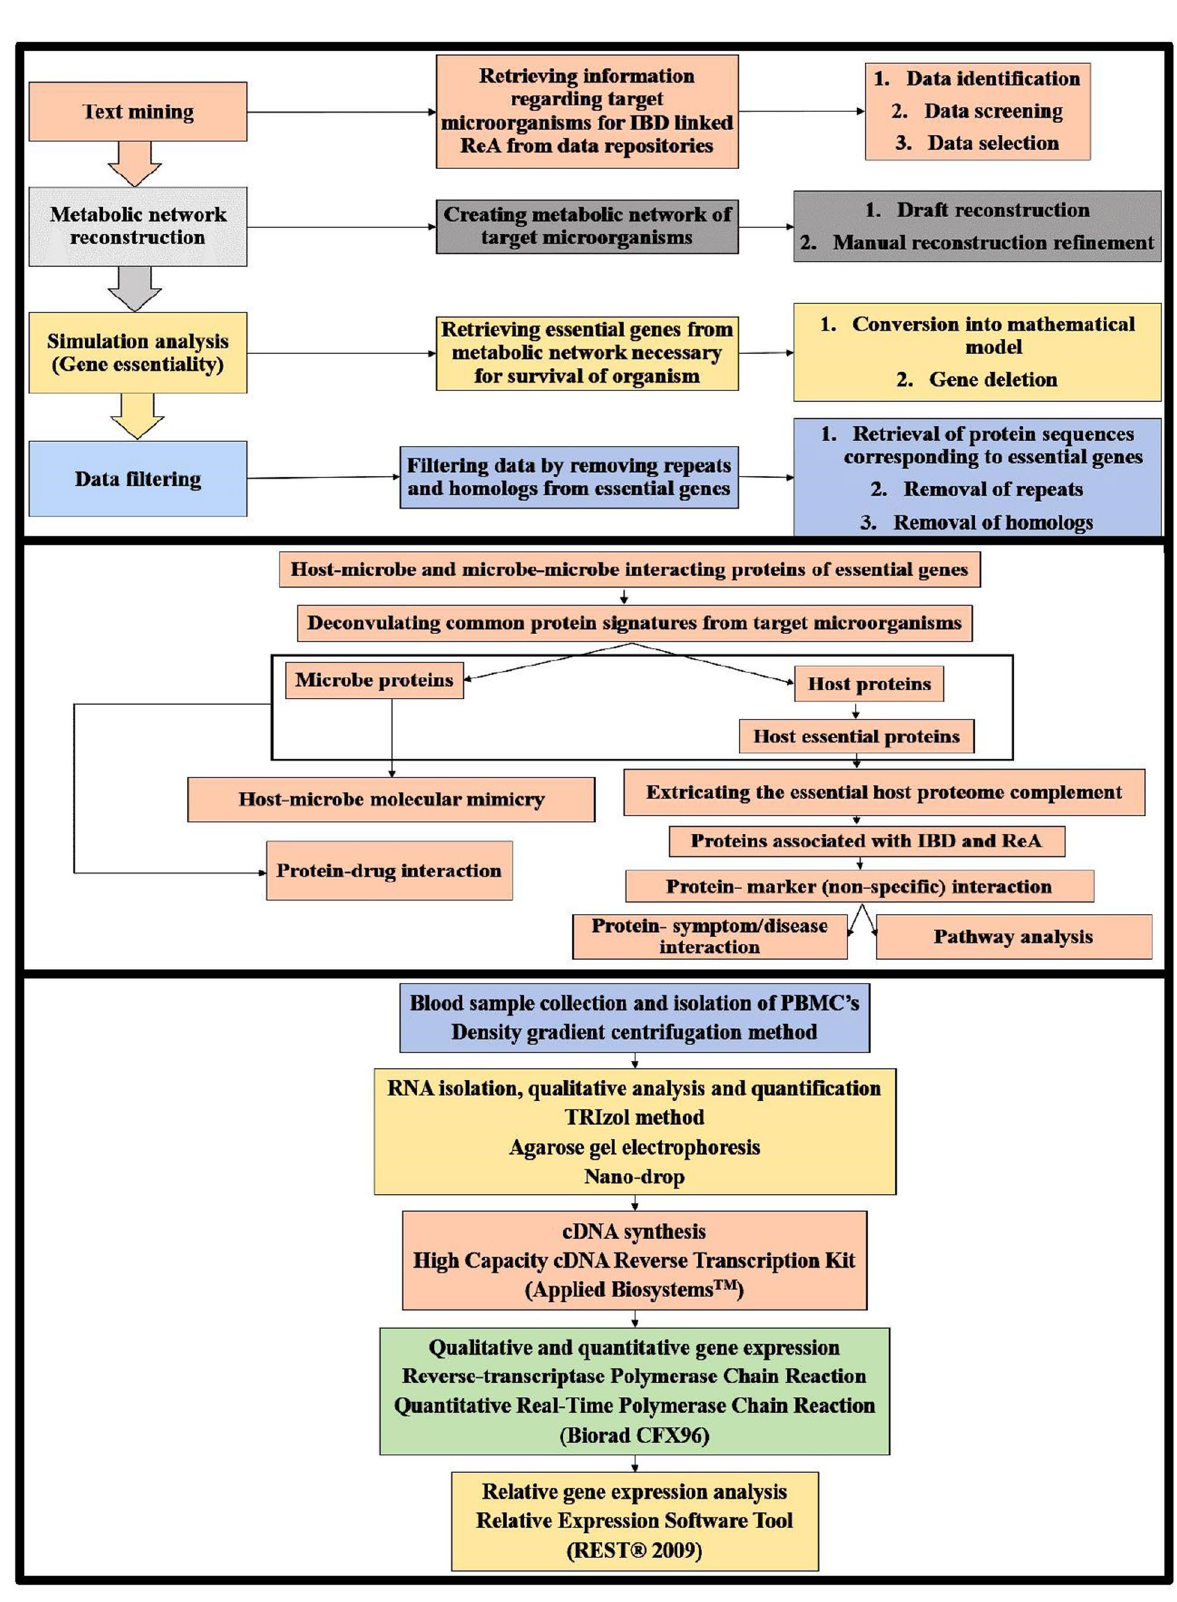
Figure 1. Methodology used for combinatorial